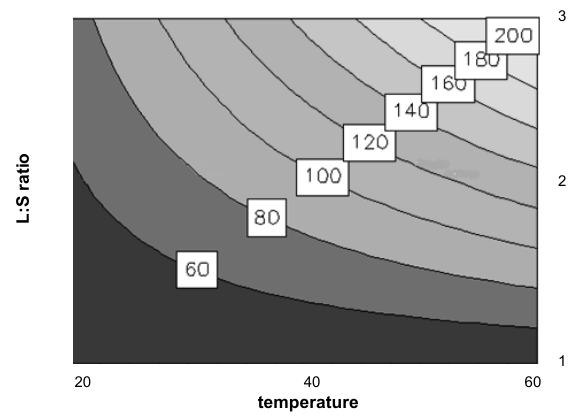
Fig. 3: Two-dimensional contour plot showing the total phenol content as a function of L:S ratio and temperature, when the percentage of EtOH was fixed at 60. L:S ratio values have been described in Tab. 1.